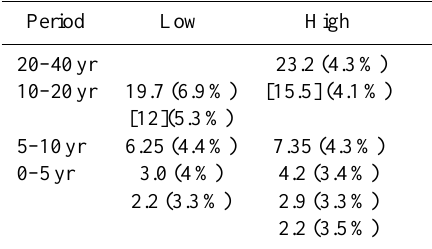
Fig. 6. Spectral estimates (in blue) for the extended Nile River time series in the interannual frequency range of 5–10yr. (a, b) Monte-Carlo SSA, and (c, d) MTM; (a, c) high-water levels, and (b, d) low-water levels. Arrows mark peaks that are highly significant against a null hypothesis of red noise; 95% error bars (for SSA) and 95% confidence level (for MTM), respectively, are in red. For SSA we used a 75-yr window and 1000 red-noise realizations, while for MTM, we took a bandwidth parameter of NW = 6 and K = 11 tapers. See information about other significant spectral peaks in Table 1. Table 1. Significant oscillatory modes in the extended Nile river records, 622–1922 AD The main entries give the periods in years: bold entries without brackets indicate that the mode is significant at the 95% level against a null hypothesis of red noise, in both SSA and MTM results; entries in square brackets are significant at this level only in the MTM analysis. Entries in parentheses provide the percentage of variance captured by the SSA mode with the given 95